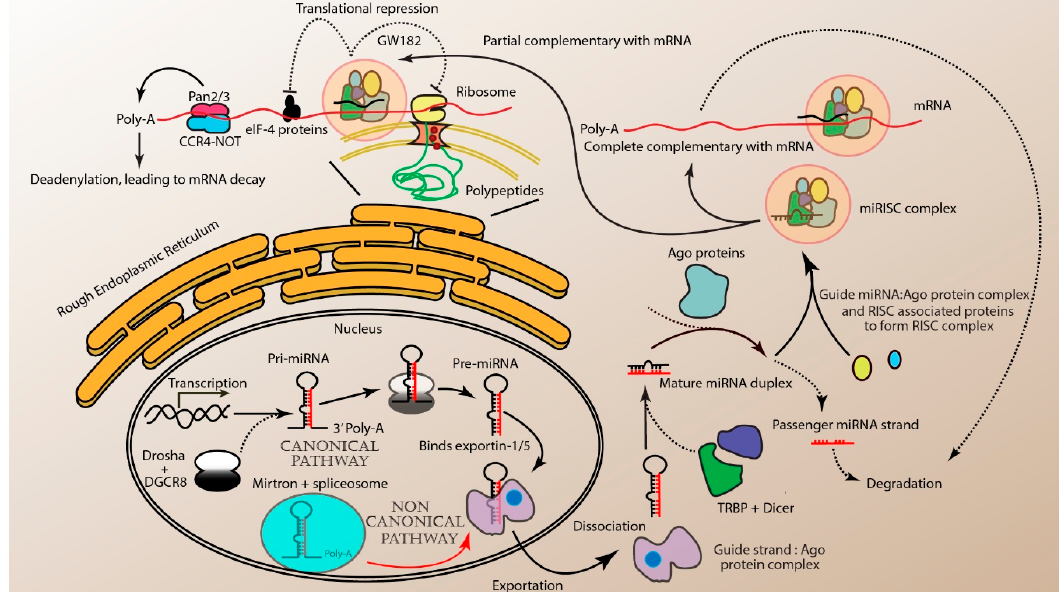
Figure 1. miRNA biogenesis: the canonical pathway begins with the transcription of miRNA genes to form the pri-miRNA. Pri-miRNA is further processed by the Drosha–DiGeorge Syndrome Critical Region 8 (Drosha–DGCR8) complex to produce precursor miRNA (pre-miRNA). Non-canonical pathway, mirtrons bypass the Drosha cleavage and instead, is cleaved by the intron-lariat- debranching enzymes. Both the pre-miRNAs are then transported to the cytoplasm by the